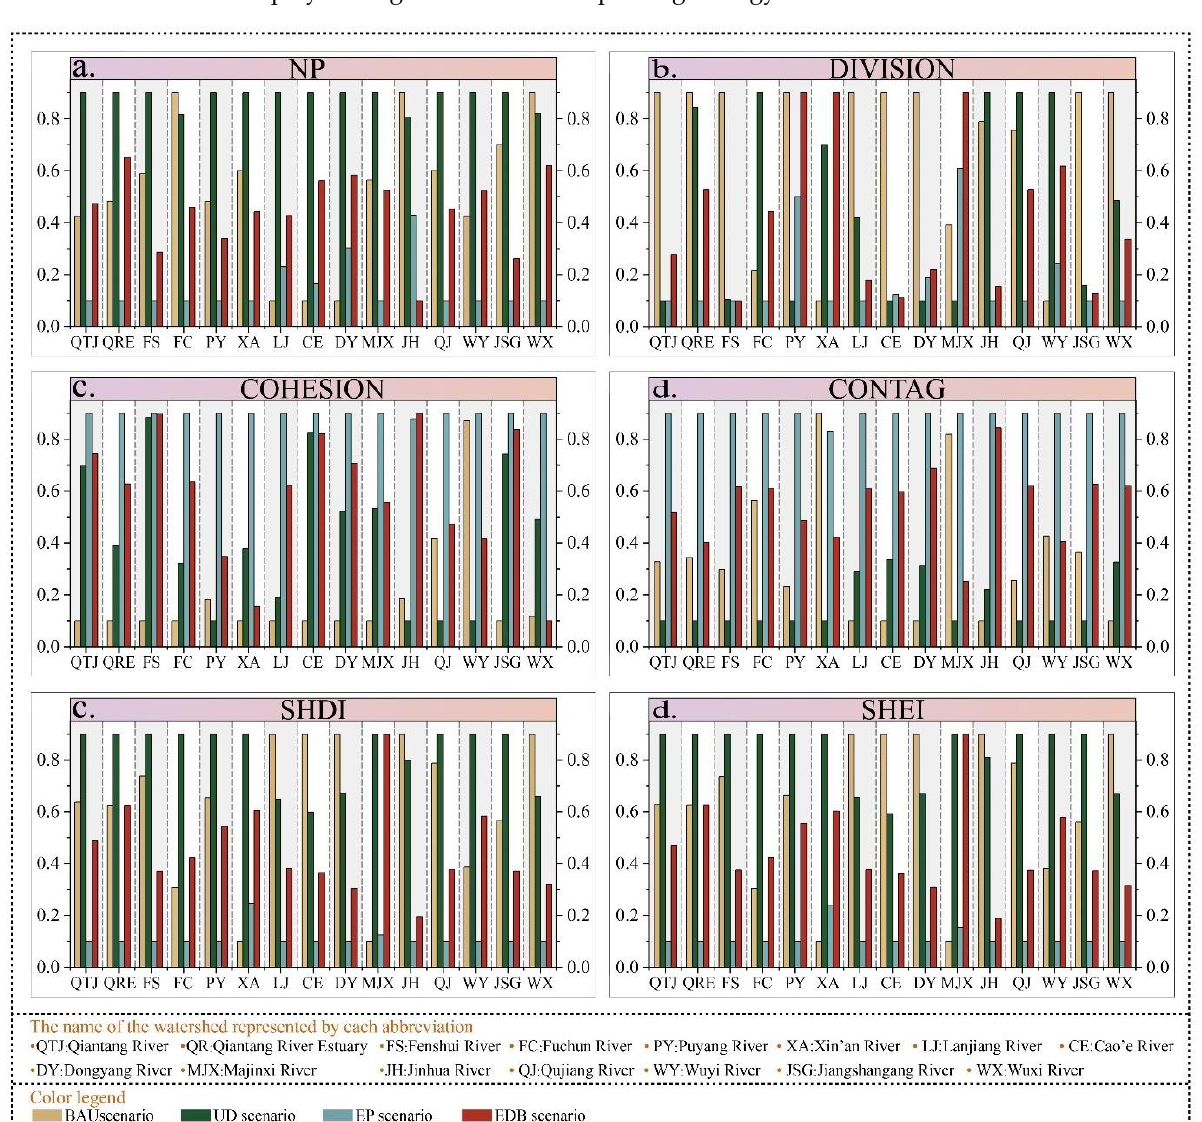
Figure 10. Landscape pattern change of Qiantang River and its sub-basins in different scenarios.